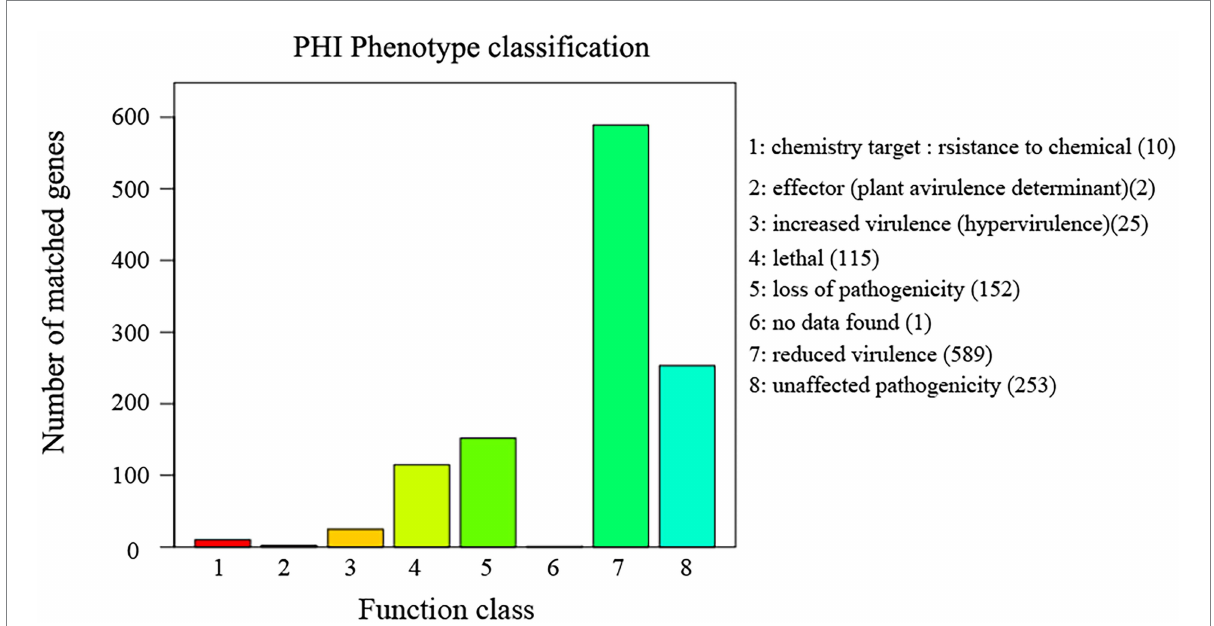
FIGURE 5 Distribution diagram of PHI phenotypic mutation type in the sample Y5 gene function annotation. PHI (Pathogen Host Interactions Database), pathogen-host interactions database, which is mainly derived from fungal, oomycete and bacterial pathogens and infects hosts including animals, plants, fungi as well as insects. This database is important for finding target genes for drug intervention studies, and it also includes antifungal compounds and their corresponding target genes. The horizontal coordinate indicates the type of phenotypic mutation and the vertical coordinate indicates the number of genes on the